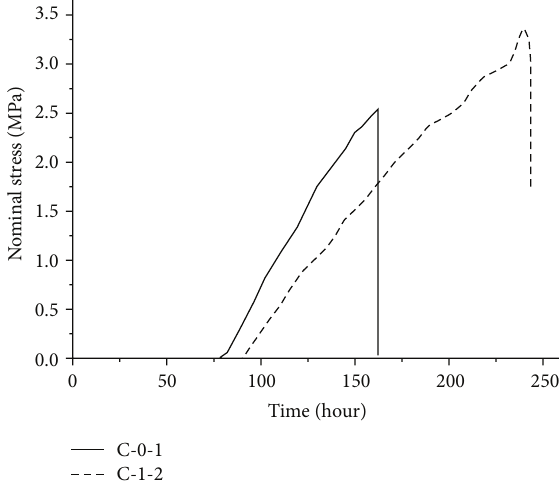
Figure 12: Concrete stress curves of C-0-1 and C-0-2. The temperature variation (Figure 8(a)) takes the following expression: